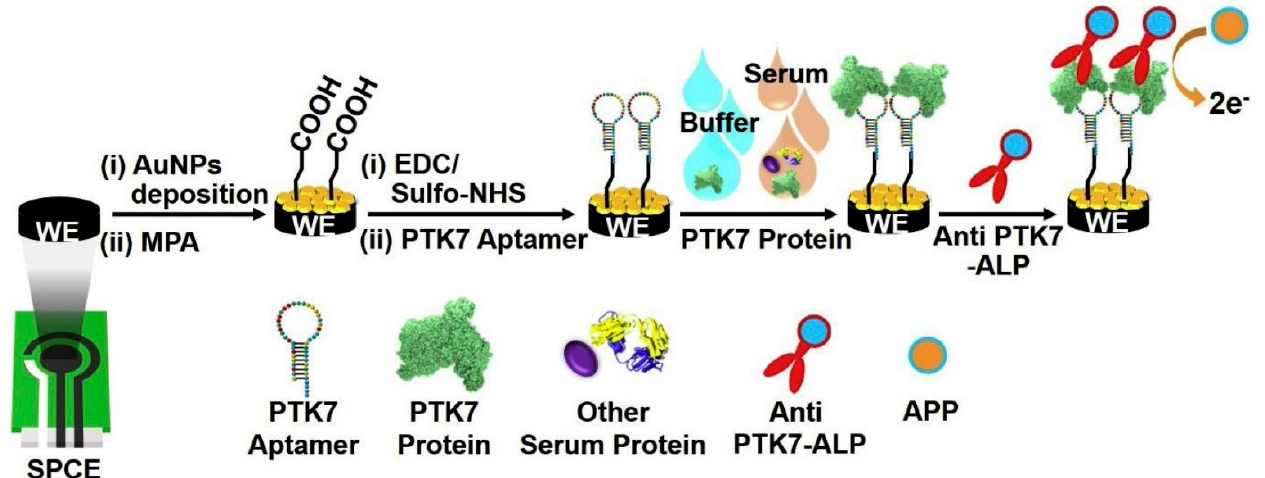
Figure 7. Schematic of the electrochemical sandwich assay for protein tyrosine kinase-7 that uses and aptamer and an antibody labeled with the enzyme alkaline phosphatase. Reproduced with permission from reference [76]. Copyright Elsevier 2021.